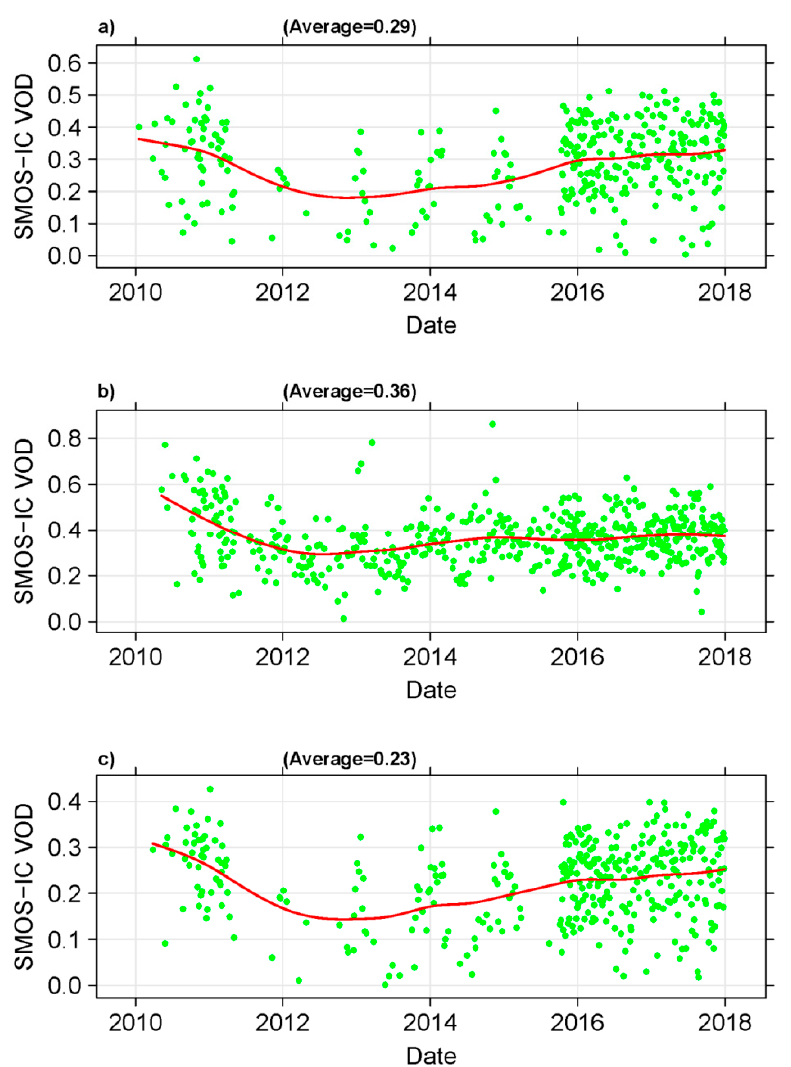
Figure 7 . SMOS-IC VOD over the ( a ) Bouron, ( b ) Bilos, and ( c ) Hermitage regions. Figure 7. SMOS-IC VOD over the ( a ) Bouron, ( b ) Bilos, and ( c ) Hermitage